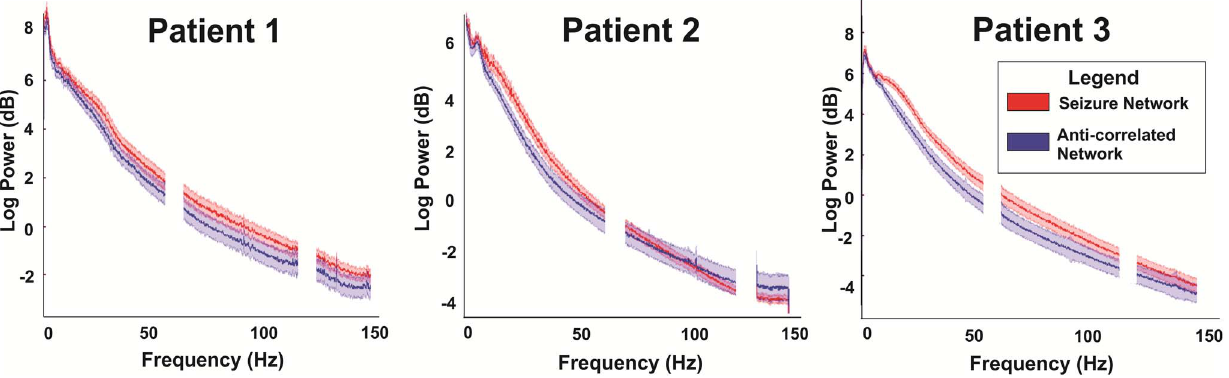
Figure 4. Patient specific log-normalized power spectral densities between the seizure and anti-correlated networks during an ictal epoch. Error bars represent 95% confidence intervals across the mean as determined by a one-sample t-test.